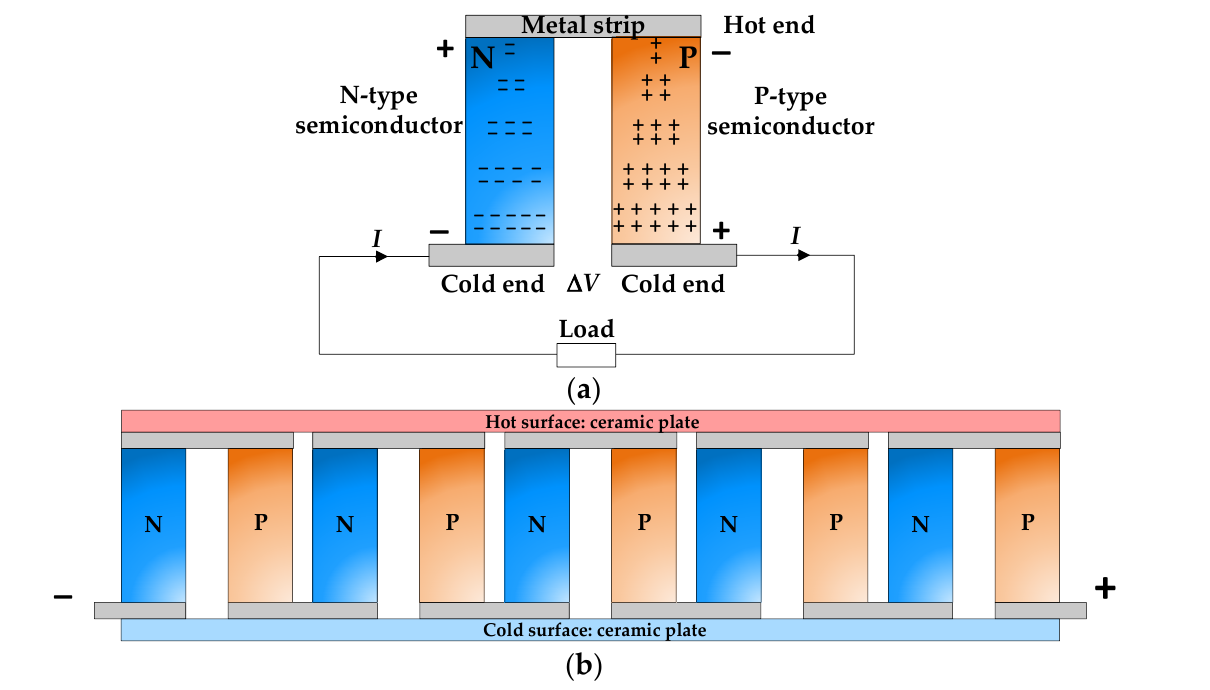
Figure 1. ( a ) Schematics of a thermoelectric generator indicating the charge carriers, adapted from [25]. ( b ) Series connections of different thermoelectric couples, adapted from [26].